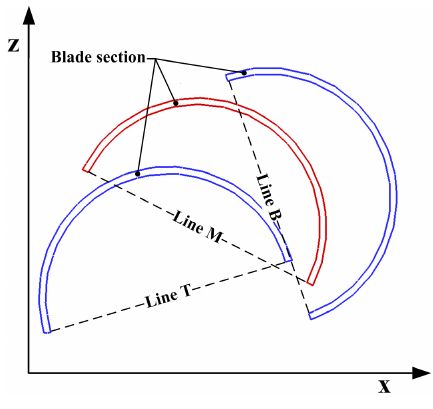
Figure 6. Top view of single blade along the rotor axis.